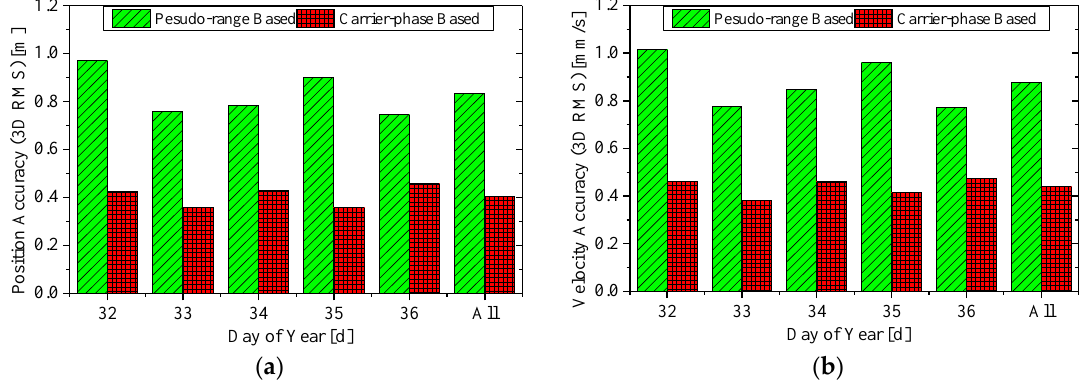
Figure 5. The accuracy (3D RMS) of real-time orbits for ZY3 satellite. ( a ) The position accuracy; and ( b ) the velocity accuracy.